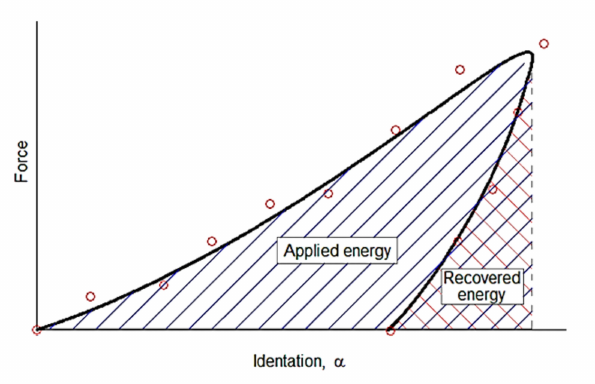
Figure 4. Evaluation of the absorbed energy due to contact during an